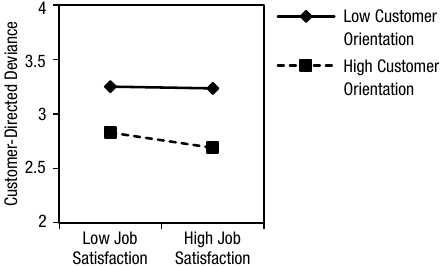
Fig. 4. Moderating role of customer orientation on job satisfaction and customer-directed